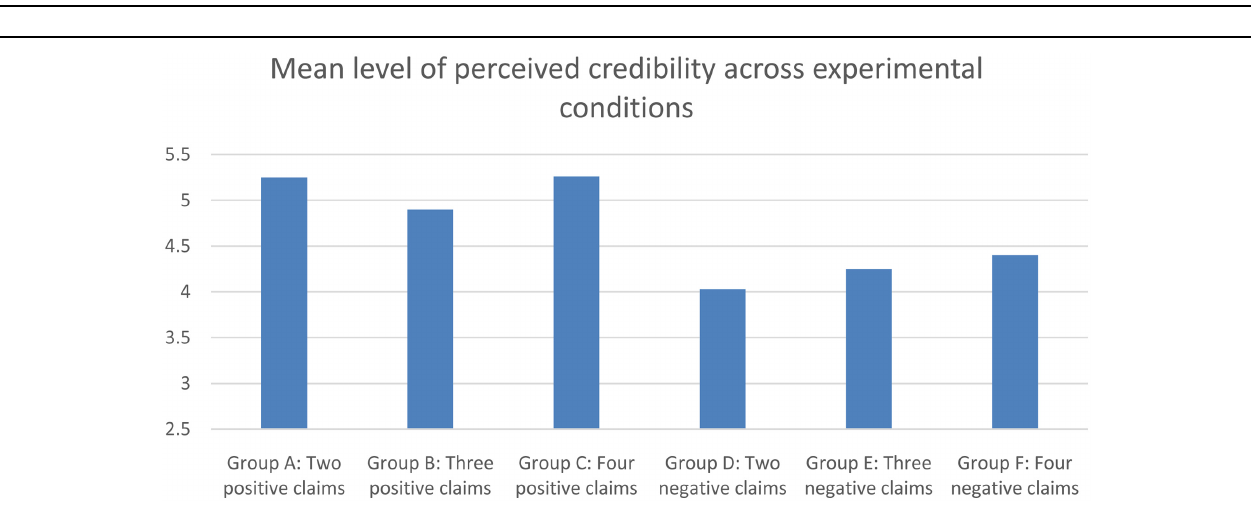
FIGURE 2 | Single item response of persuasion knowledge, across experimental conditions.